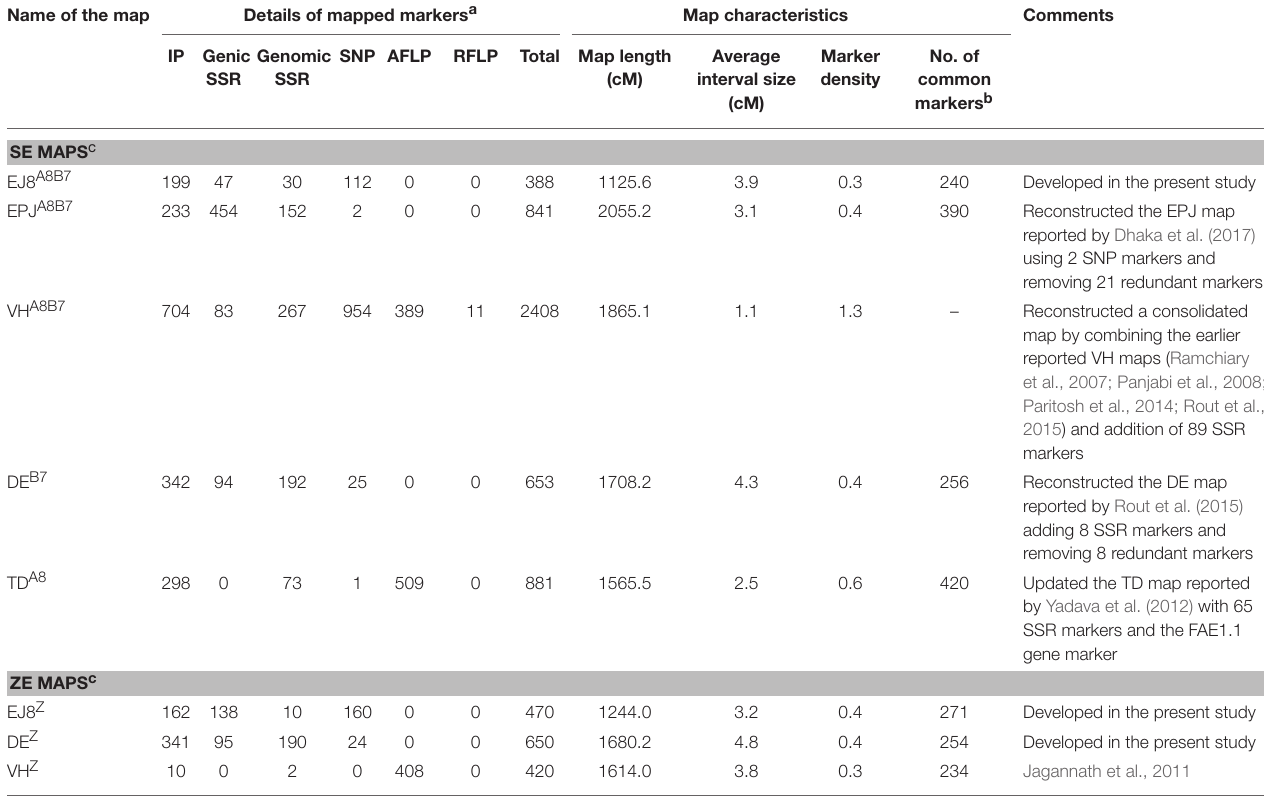
TABLE 3 | Summary of the five SE and three ZE bi-parental genetic maps. Name of the